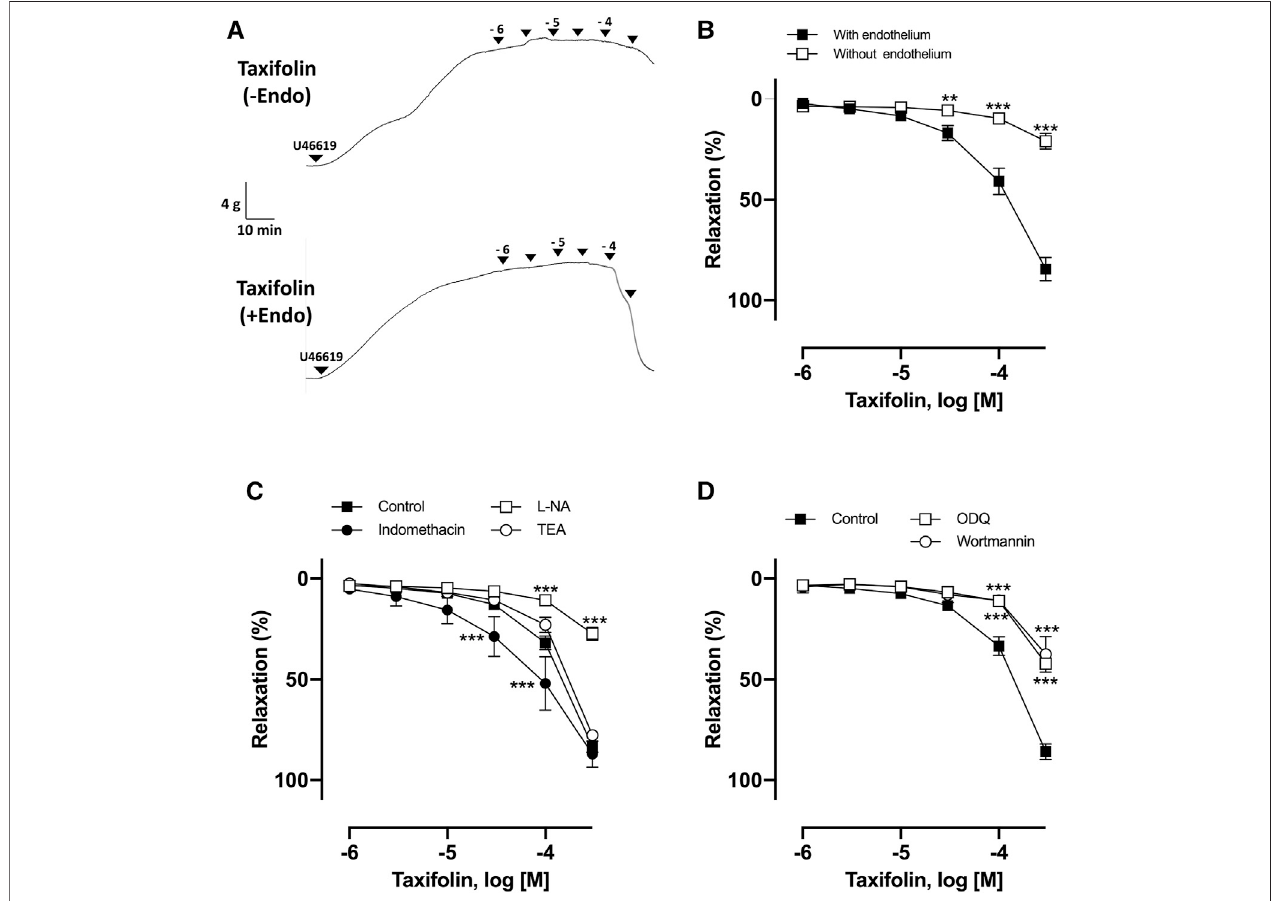
FIGURE 5 | Characterization of endothelium-dependent relaxation to taxifolin in coronary artery rings. (A) Representative original tracing of the concentration- relaxation curve. (B) Intact and endothelium-denuded rings were contracted using U46619 before the addition of increasing concentrations of taxifolin (1 – 300 μ M) to construct concentration-relaxation curves. *** p < 0.001 vs with endothelium. ** p < 0.01 vs endothelium. (C) Intact rings were incubated with the NO synthase inhibitor (L-NA, 100 μ M), cyclooxygenase inhibitor (indomethacin, 10 μ M), and non-selective potassium channel blocker (TEA, 1 mM), in addition to (D) guanylyl cyclase inhibitor (ODQ, 10 μ M) and PI3K inhibitor (wortmannin, 30 nM). Results are presented as mean ± SEM of 8 – 10 experiments. ***p < 0.001 vs control.